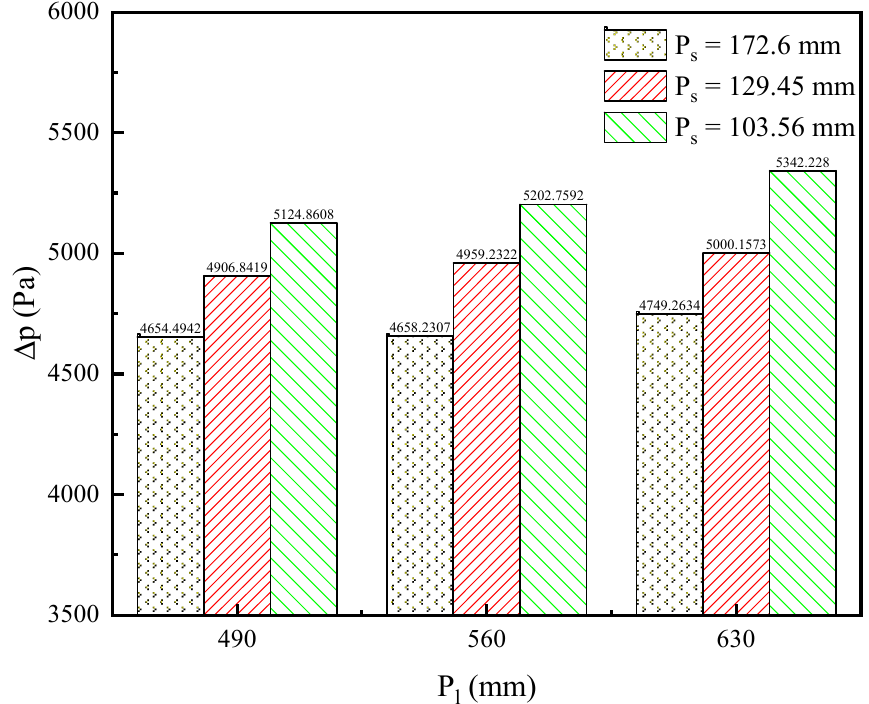
Figure 16. Schematic diagram of pressure drop changes under different working conditions.